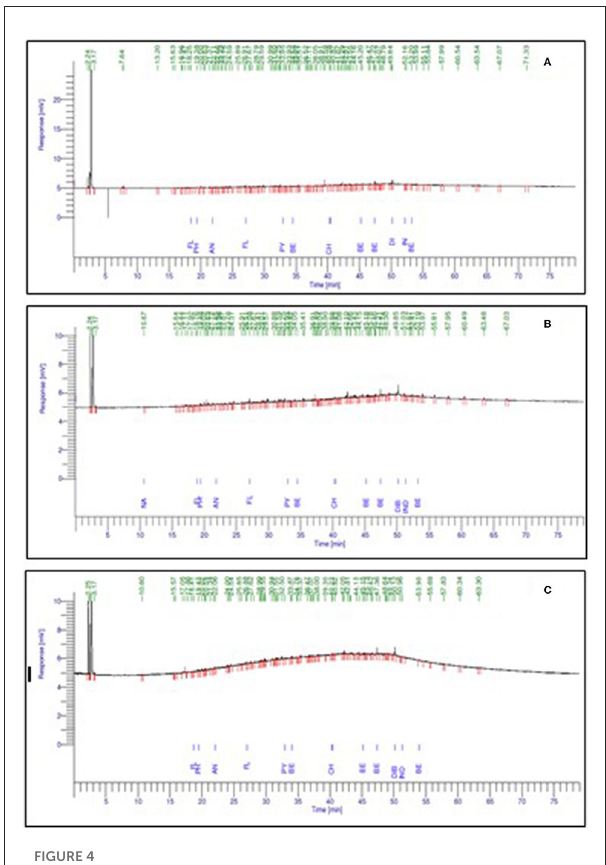
FIGURE4 Representation of a gas chromatogram of the aromatic fraction of crude oil of wells, where (A) Well 70, (B) Well 127, and (C) Well 174.